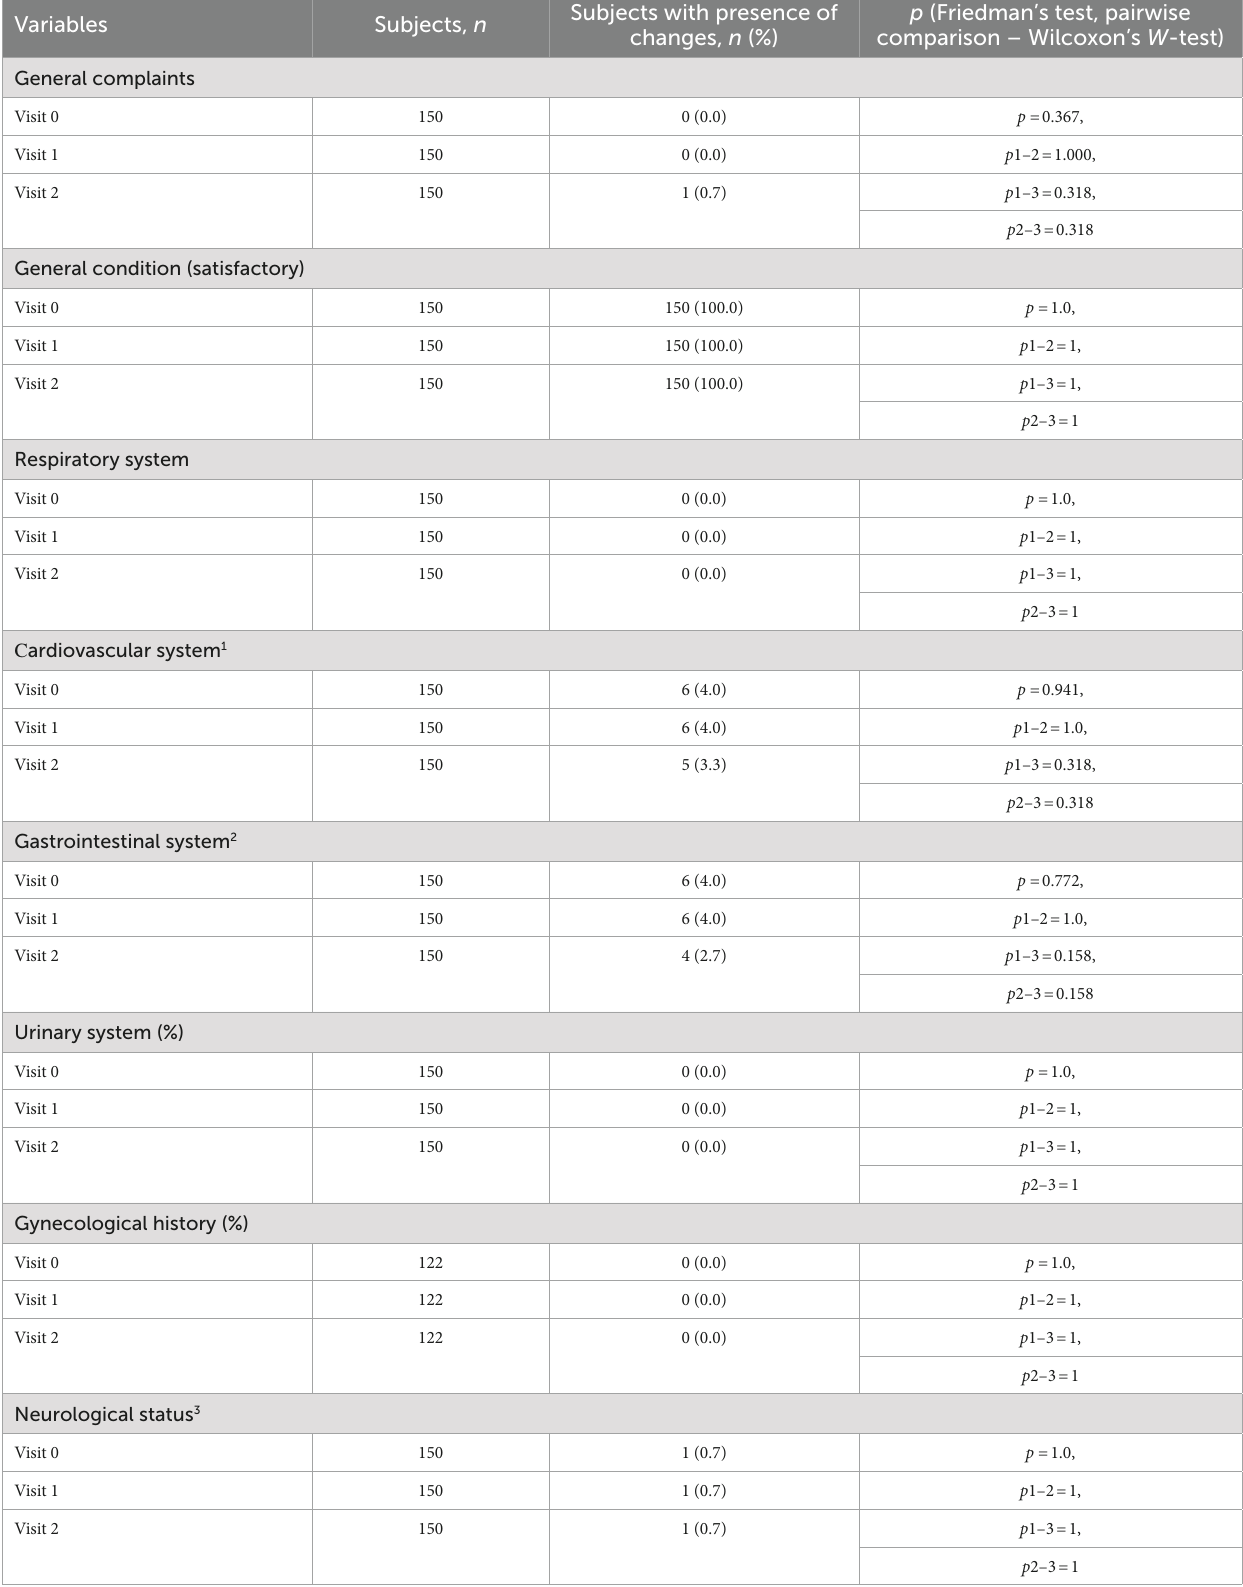
TABLE 4 Dynamics of parameters over time based on the results of examination of patients. Variables Subjects, n